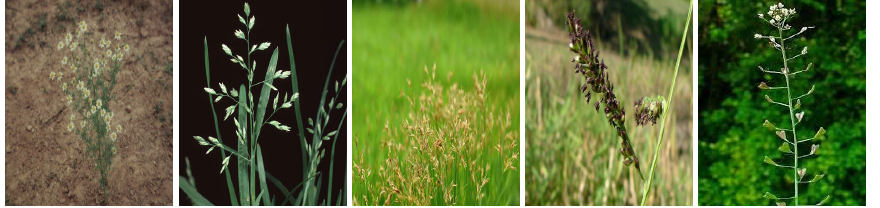
Figure 4. From left to right: Mayweed, Meadow grass, Nutsedge, Paragrass, Shepherd’s purse (Source: [41]).